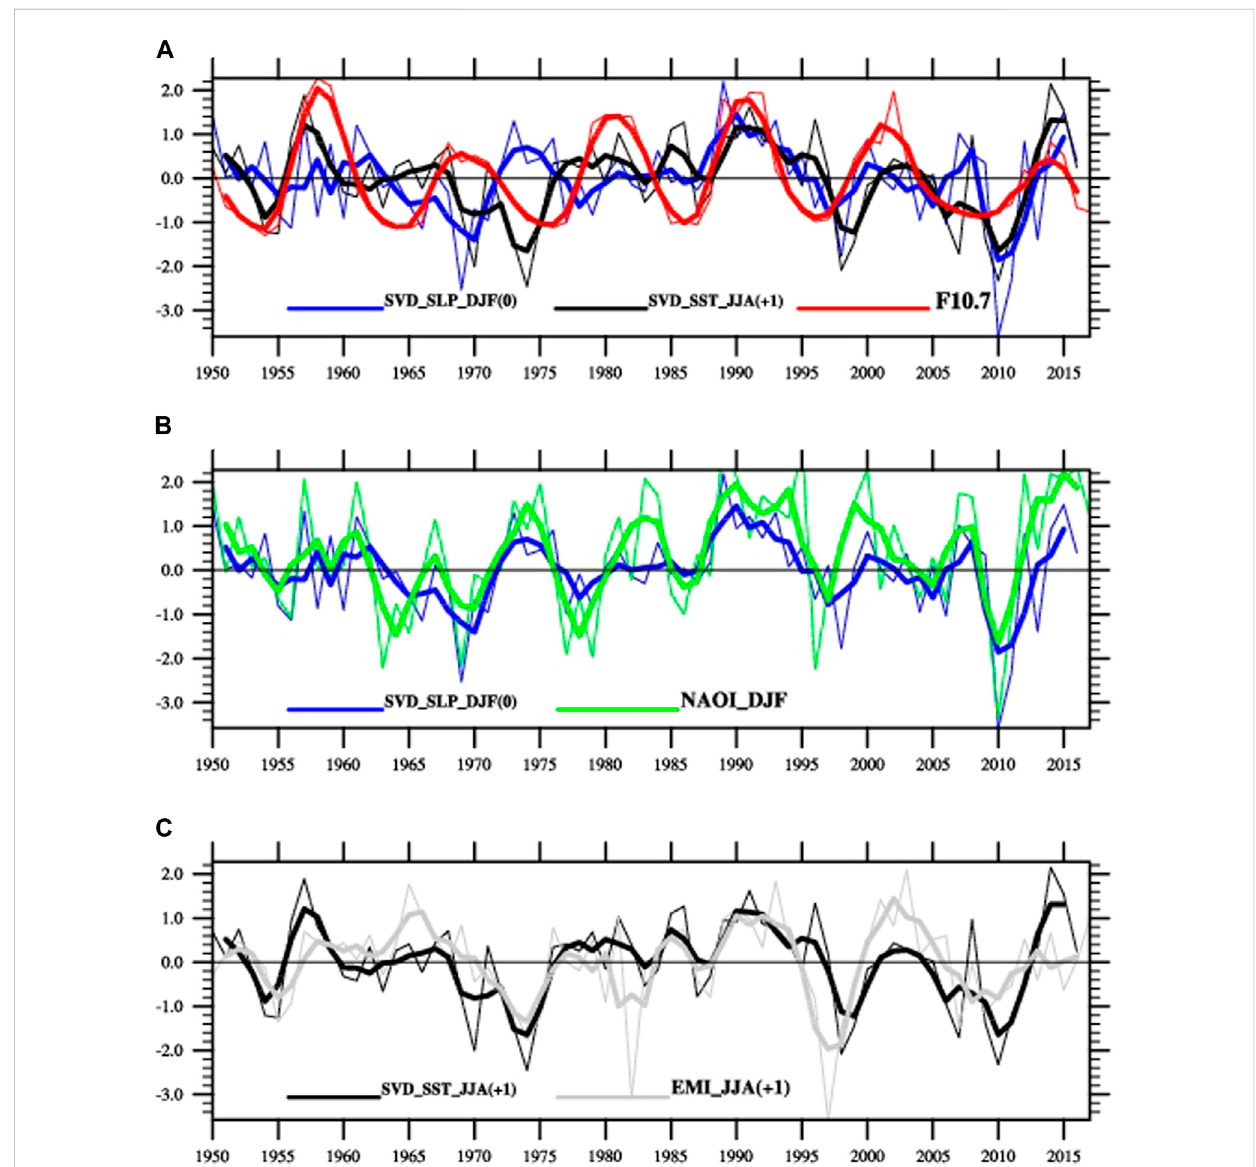
Table 1. Signi fi cance levels of the correlation coef fi cients and regression coef fi cients are assessed by the two-tailed Student ’ s t-test. The effective degrees of freedom of the time series in the correlation and regression analysis are calculated following the method used by Huo et al. (2023). A composite mean difference method based on the solar cycle (Camp and Tung, 2007; Zhou and Tung, 2012) is used to assess the responses in the simulation and observation. The 90% statistical signi fi cance of the composite results was estimated by a 1000-fold bootstrapping test with replacement (Diaconis and Efron,